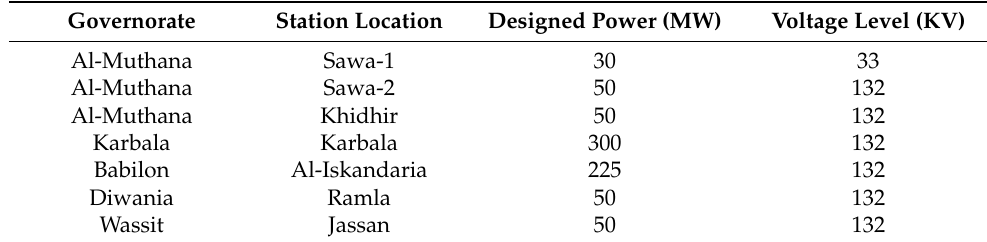
Table 1. Suggested solar energy stations with its